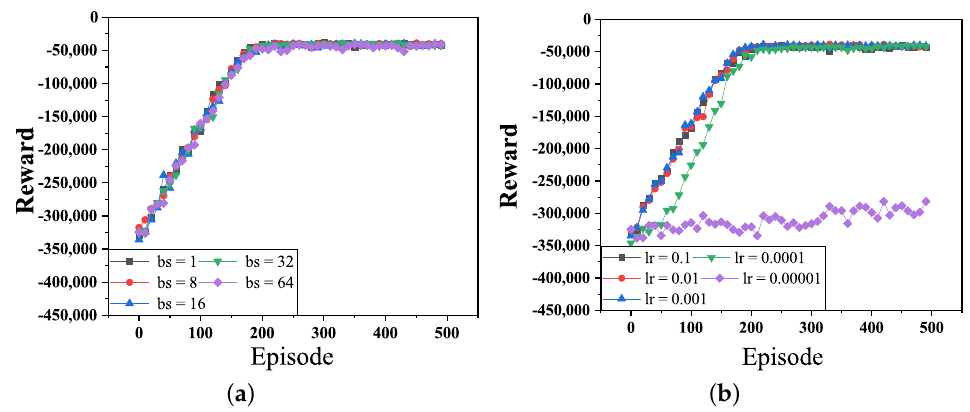
Figure 4. Simulation results under different parameter settings over 500 episodes. ( a ) Batch Size; ( b ) Learning